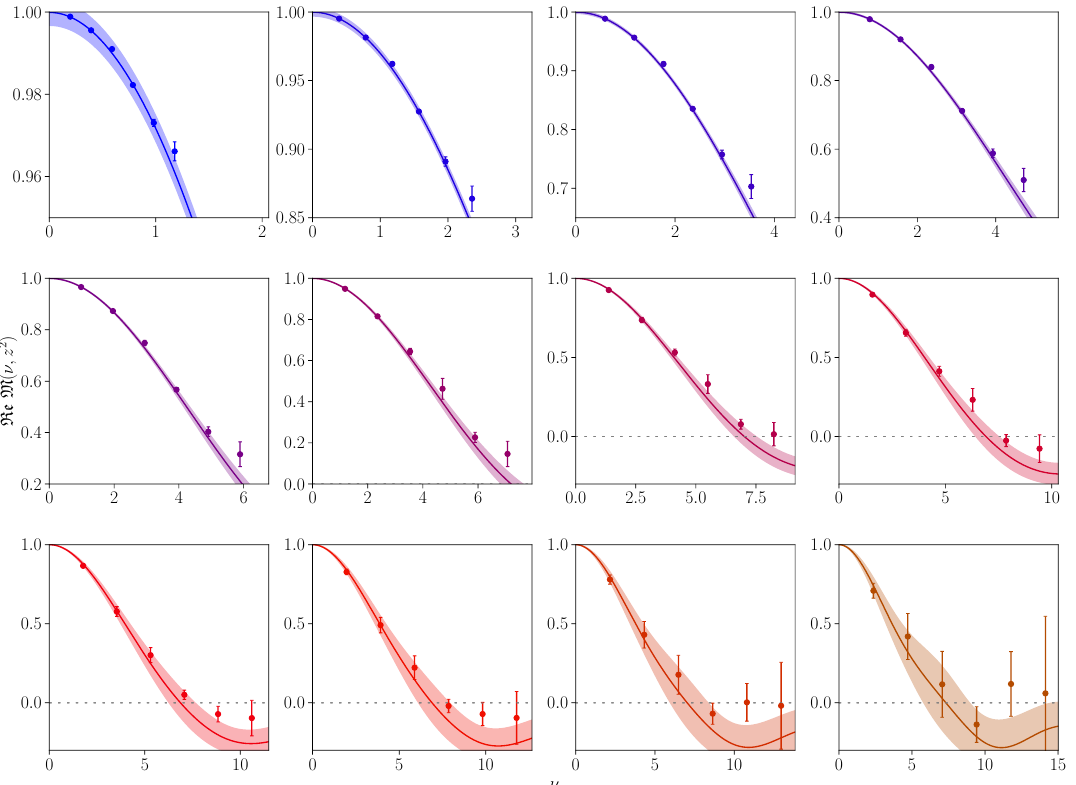
Figure 15. Fit to the real component of the unpolarized reduced pseudo-ITD where the leading- twist, discretization, twist- 4 , and twist- 6 corrections have been expanded in Jacobi polynomials up to order { n = { 4 , 1 , 3 , 2 } . Starting from the upper left panel and traversing lt , n az , n t 4 , n t 6 } v v horizontally, the leading-twist plus corrections are shown for each z/a ≤ 12